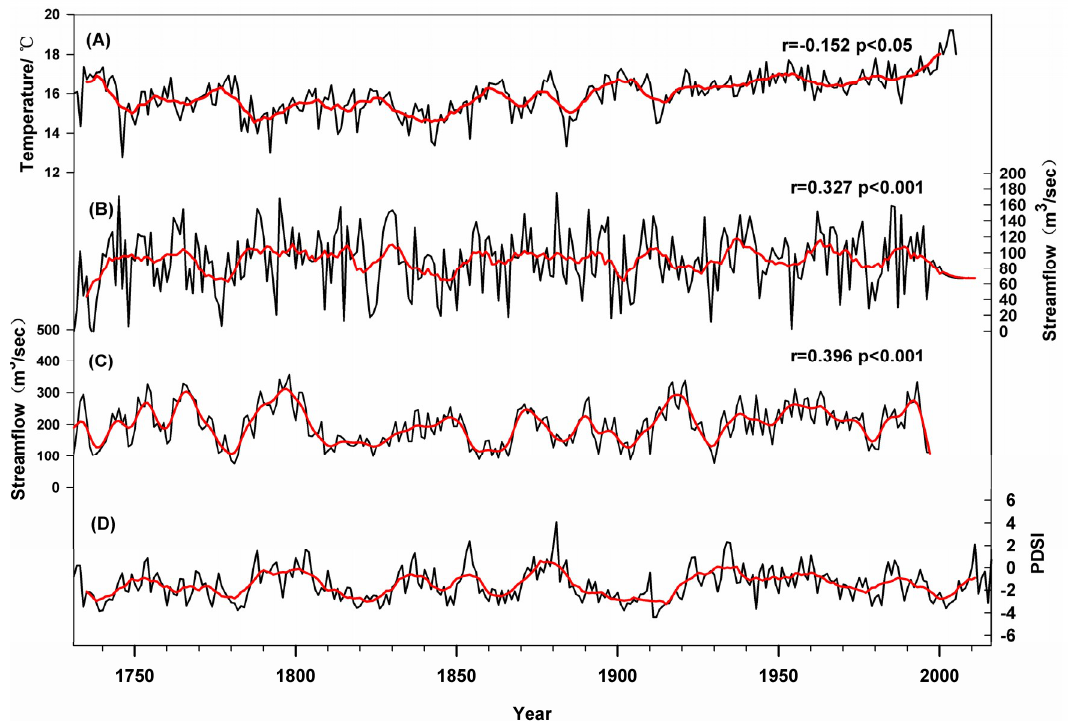
Figure 9. Comparisons between ( A ) summer temperature reconstruction in North of Mongolia from Davi et al. (2015), ( B ) Yeruu River, Mongolia 300-Year Streamflow Reconstruction (Perderson et al. 2012), ( C ) Selenge River, Mongolia Streamflow Reconstruction (Davi et al. 2006), and ( D ) PDSI reconstruction of this study.